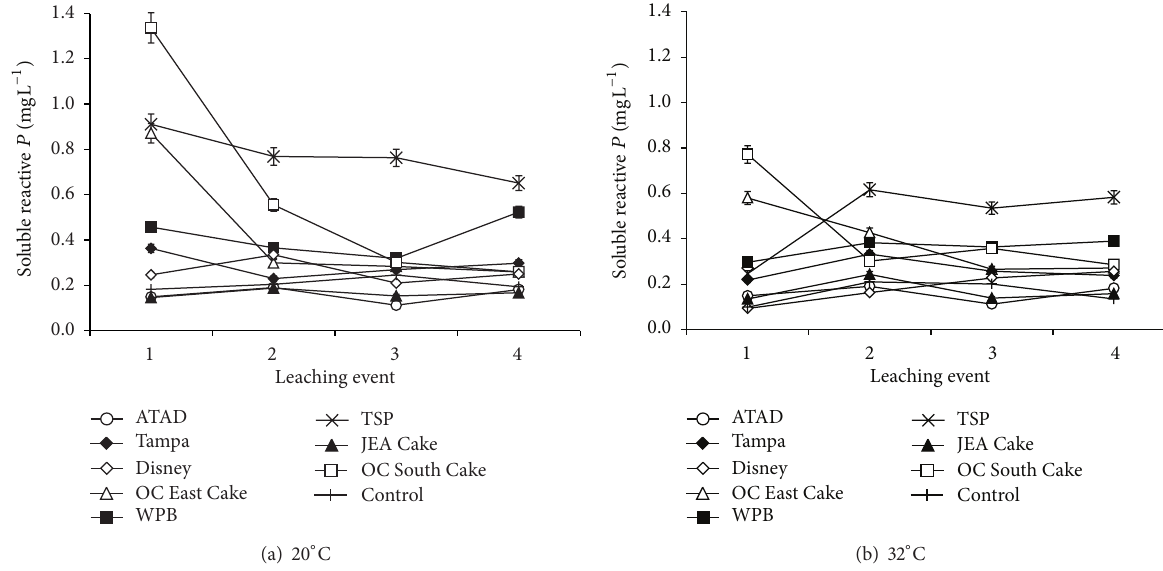
Figure 2: Leachate soluble reactive P (SRP) concentrations. Leaching events 1, 2, 3, and 4 correspond to 15, 30, 60, and 90d of incubation. P rate 112mgPkg −1 (224 kgPha −1 ). Error bars represent one standard error. Data represent the average of three replicates. Open symbols represent biological nutrient removal